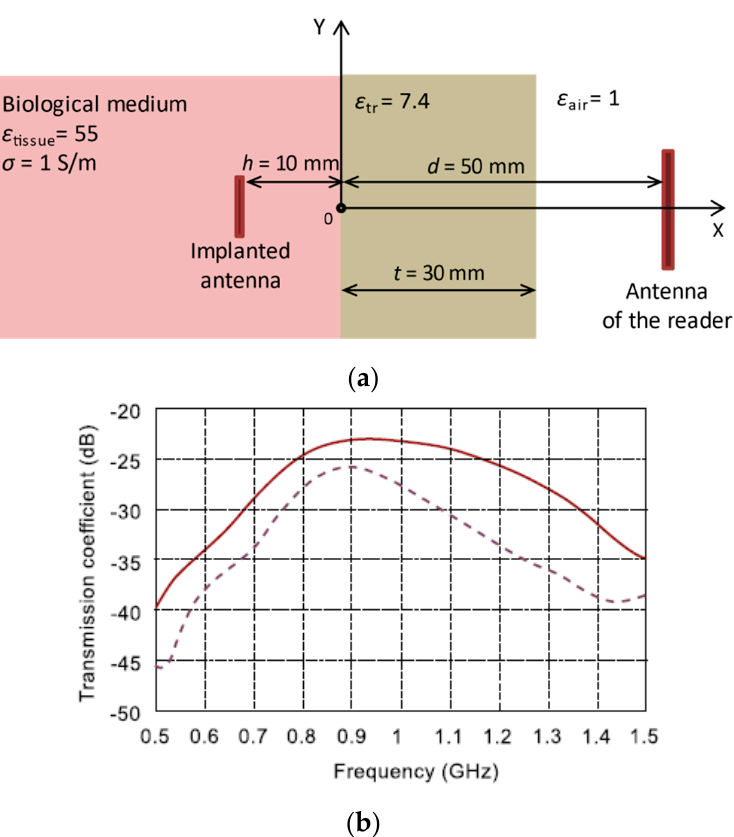
Figure 8. ( a ) A scheme of the structure containing the i mplanted antenna with matching layer placed between the biological tissue and the reader antenna; ( b ) the transmission coefficient between the antennas: Transmission coefficient is shown by the solid line for the structure with matching layer and by the dashed line without it.